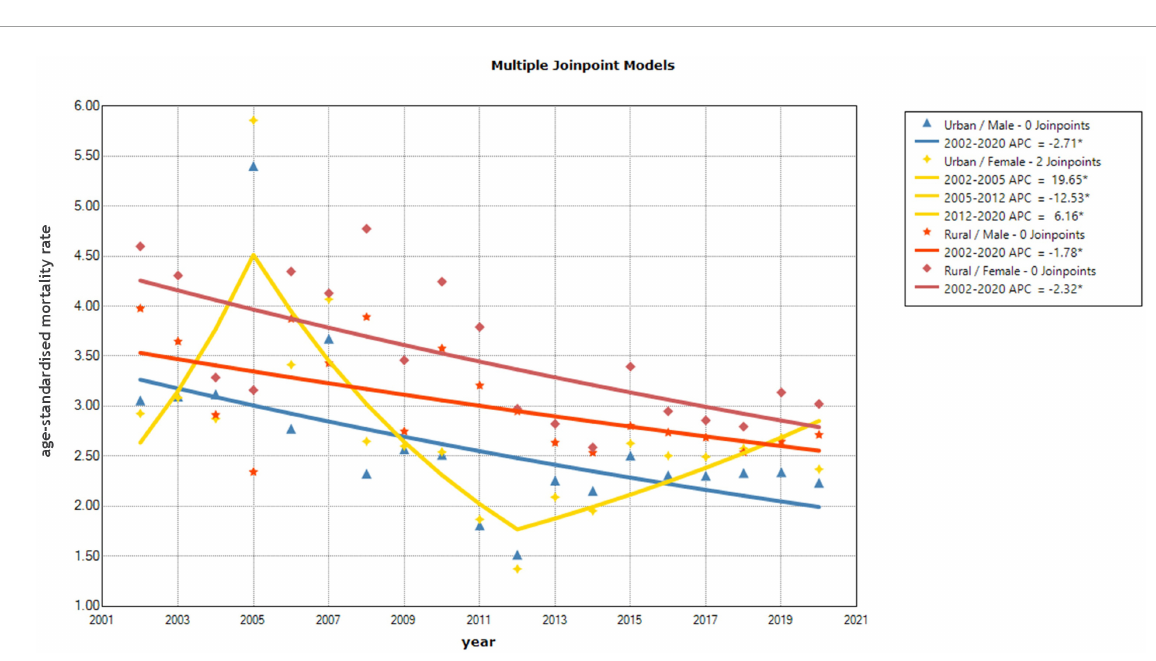
The risk of death from mental disorders increased by 28% (95% CI 1.23–1.32, P < 0.0001) per 5 years of age in the same sex and region. Each year, the risk of death decreased by 3% (95%